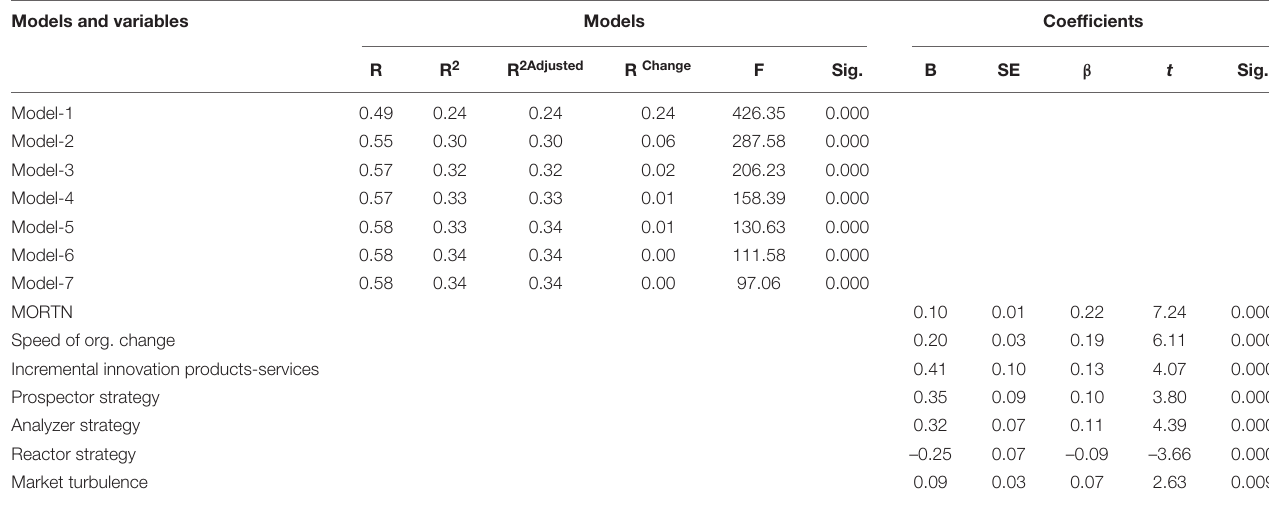
TABLE 3 | Summary of the models, predictive variables, and coefficients of regression analysis (stepwise method): clan culture (Peruvian subsample n 2 = 1,317). Models and variables